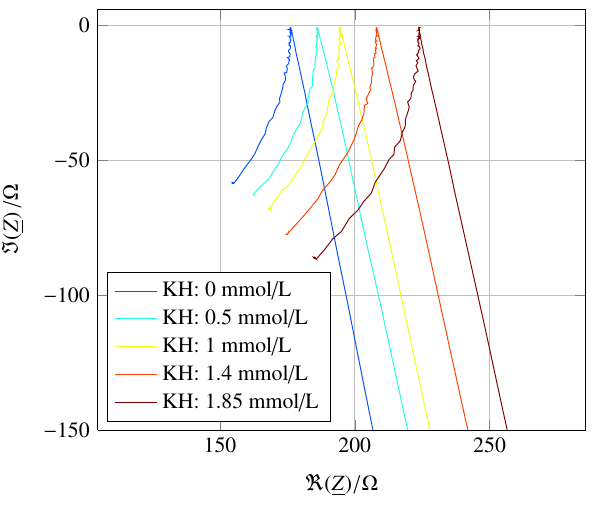
Figure 6. Impedance spectra of water samples with the same total hardness and different carbonate hardness.